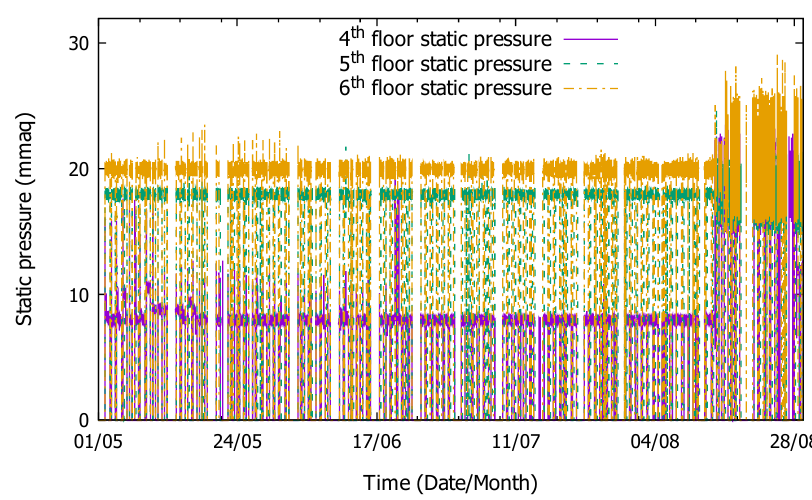
Figure 7. Comparison of static pressure of each